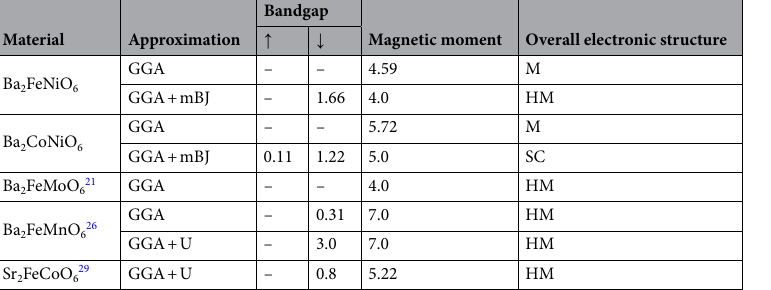
Table 2. Calculated band gap (E g in eV) and magnetic moment ( μ B per formula unit) of Ba 2 BNiO 6 materials in comparison with similar other double perovskites. M metallic, SC semiconducting, HF half-metallic.